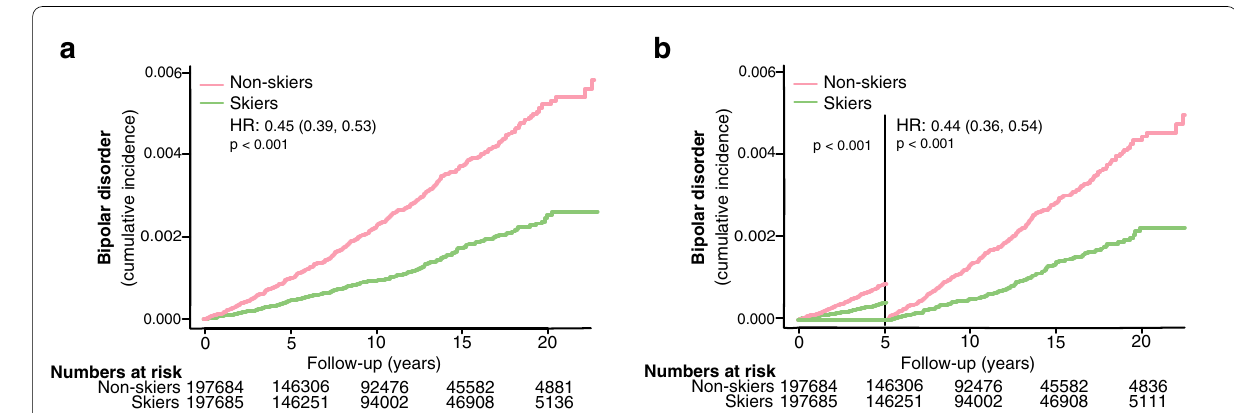
Fig. 1 The risk of developing bipolar disorders in skiers compared to non-skiers ( a ) and the risk of developing bipolar disorders more than 5 years after completing the ski race ( b ). HR represents hazard ratios from an unadjusted C ox